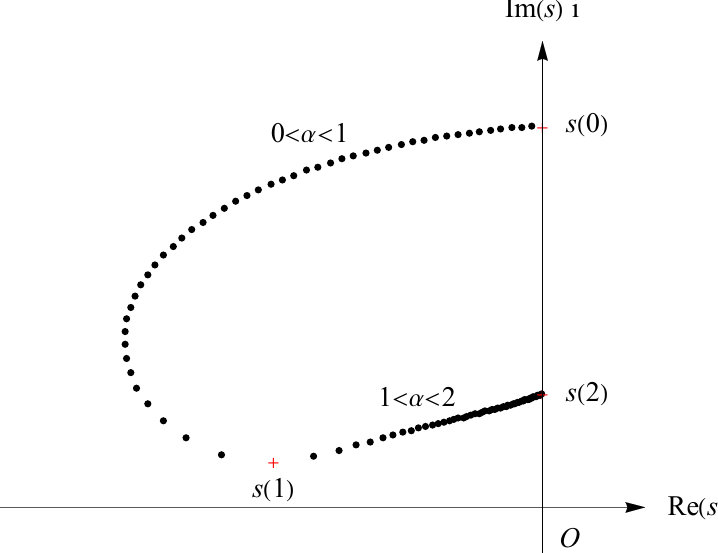
Figure 13. Trajectory of roots s ( α ) for α varying between 0 and 2, where b = 0.9 and c = 0.6 ( b 2 − 4 c < 0, region III) .